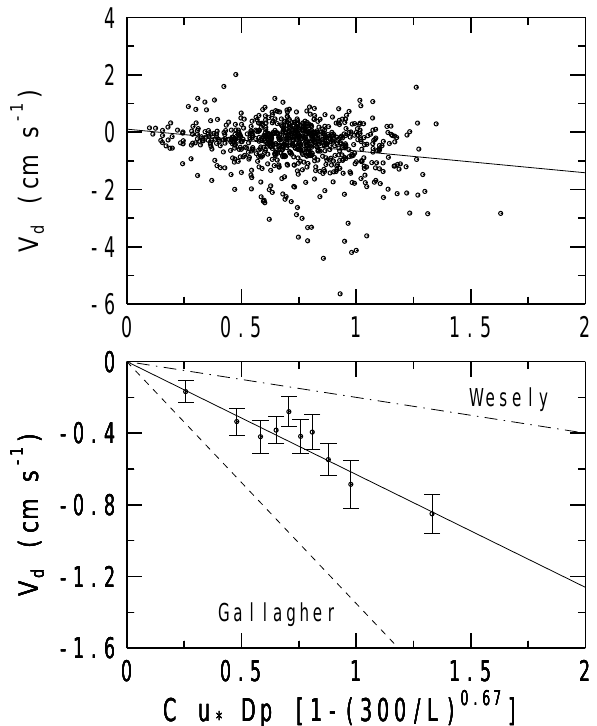
Fig. 8. Parameterization of aerosol deposition velocity ( V d ). The points represent the relationship between parameterized V d (X axis- calculated from Eq. 5) and measured V d (Y axis) from BEARPEX. The upper panel compares 30min values while the bottom panel compares bin averaged values. The lines in the bottom panel repre- sent different coefficients ( c ) in the parameterization described by Eq. (5): the solid line has c =0.63 as the best fit to BEARPEX 2007 V d observations; the dash line has c =1.35 from Gallagher’s V d data over forest; and the dot/dash line has c =0.2 from Wesely’s V d data that were collected over grass (bars describe ± one data standard